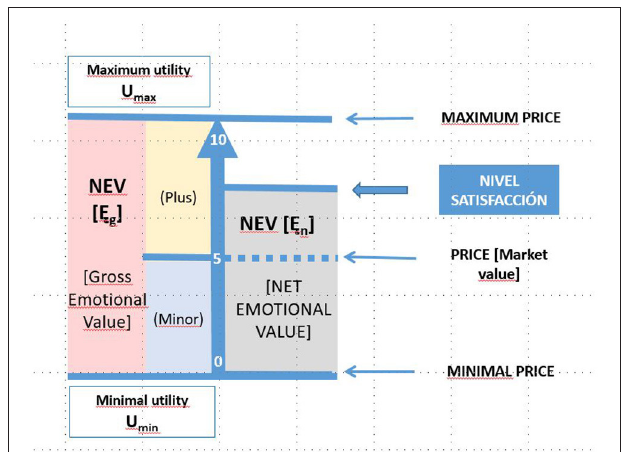
FIGURE 4 | Net emotional value. Source: own compilation. (1) The numbers in white located on the horizontal axis are only decimal references to make the information easier to see; under no circumstances should it be assumed that the percentages of each value must be related to them. (2) Should the price not match the market value due to market failure, the appropriate corrections would have to be